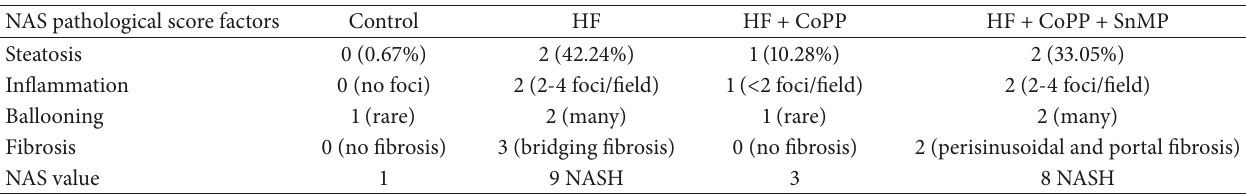
Table 1: Histopathological NA S sco r e evaluation. Degree of steatosis and NASH (grade 0 ≤ 5%; 1 = 5–33%; grade 2 = 34%–66%; grade 3 ≥ 66%), lobular inflammation (0: no foci, 1 < 2 foci per 200x field, 2: 2 to 4 foci per 200x field, and 3: foci per 200x field), hepatocyte ballooning (0: none; 1: rare or few; 2: many), and fibrosis (0: no fibrosis, 1: perisinusoidal or periportal fibrosis, 2: perisinusoidal and portal/perioral fibrosis, 3: bridging fibrosis, and 4: